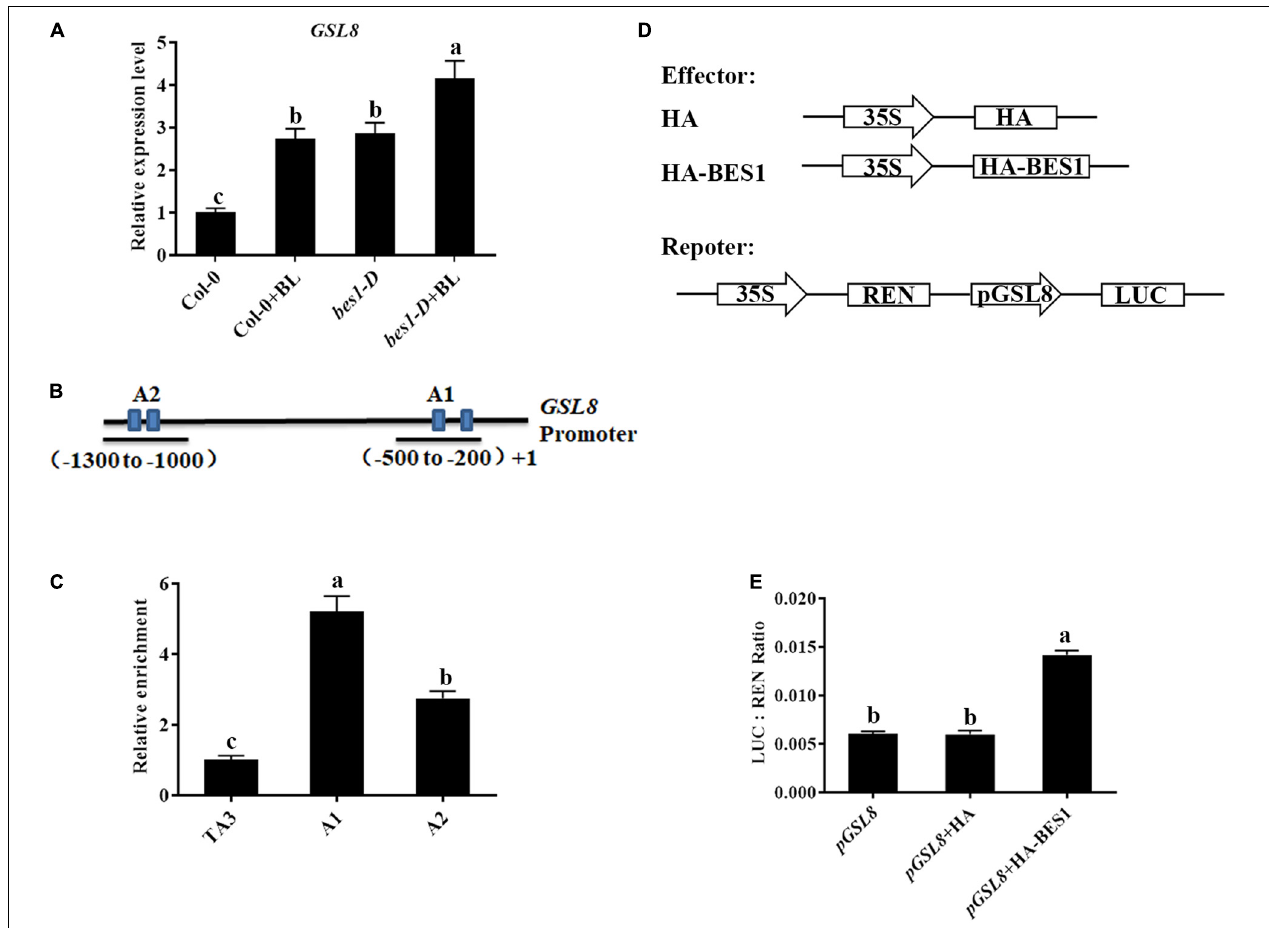
FIGURE 9 | GLUCAN SYNTHASE-LIKE 8 is a direct target of BES1. (A) Detection of GSL8 expression in Col-0 or bes1-D with/without BL treatment. Quantitative reverse-transcription PCR (qRT-PCR) was performed using 4-week-old plants treated with or without 1 µ M BL. Data presented are mean ± SD from three independent experiments. (B) Schematic representation of GSL8 promoter. (C) Chromatin immunoprecipitation (ChIP)-quantitative PCR (qPCR) assay using 4-week-old Col-0 seedlings. TA3 was used as an internal control. Data presented are mean ± SD from three independent experiments. (D) Schematic diagrams of the reporters and effectors used in the transient transactivation assays. (E) Transient dual-luciferase (LUC) reporter assays show that BES1 enhances the promoter activity of GSL8 . The relative LUC activities were calculated by normalizing the LUC values against Renilla LUC (REN). Data presented are mean ± SD from three independent experiments. Significant differences ( P < 0.05) are denoted by different lowercase